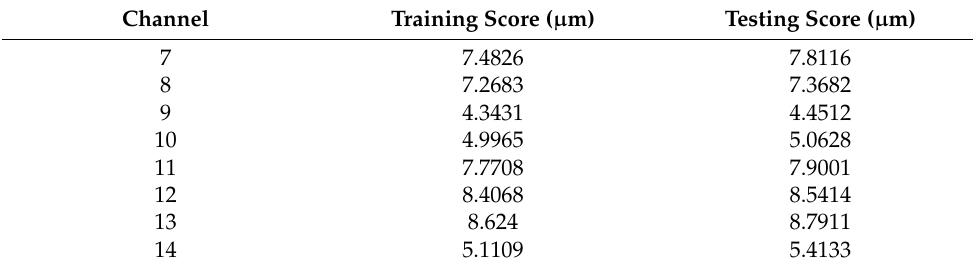
Figure 5. The images of brightness temperature on 30 January 2021.